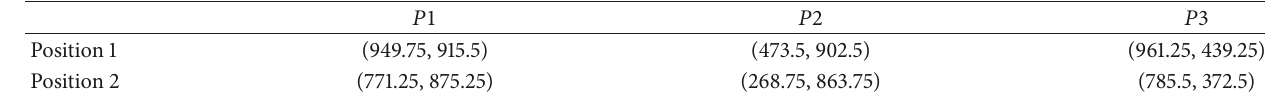
Table 4: Data after direction calibration.